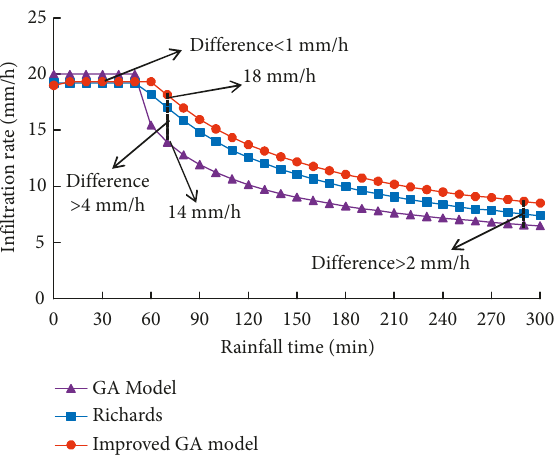
Figure 12: Infiltration rate of the slope with rainfall duration.